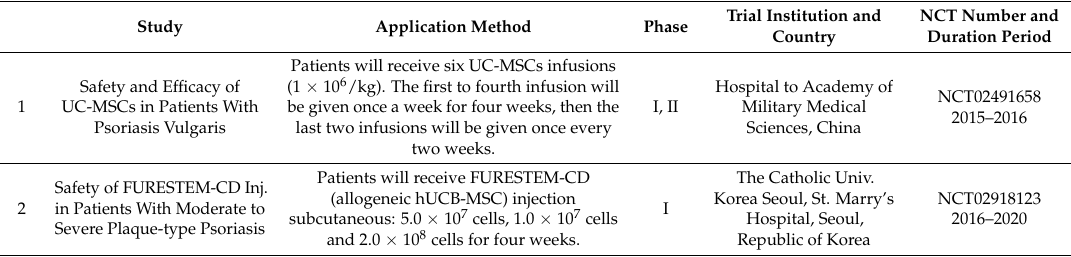
Table 3. List of past and present clinical adipose-derived stem cell trials in psoriasis [95].